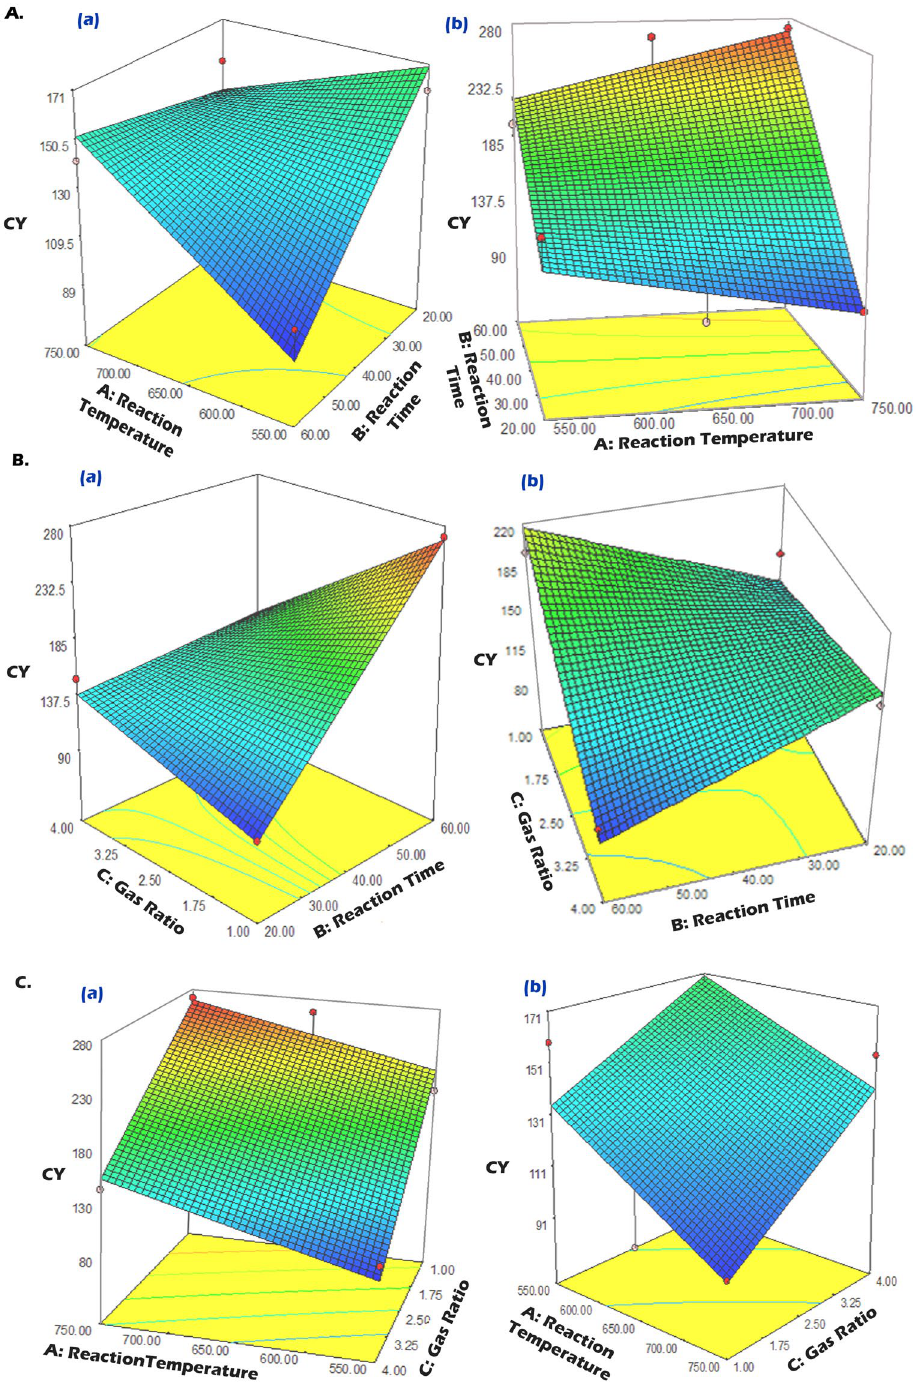
Figure 3. Response surface plots for the effects of reaction temperature and reaction time on CY at fixed gas ratio 4.0 ( Aa ) and 1.0 ( Ab ); effects of reaction time and gas ratio on CY at fixed reaction temperature 750 ( Ba ) and 550 °C ( Bb ); and effects of gas ratio and reaction temperature on the CY at fixed reaction time 60 ( Ca ) and 20 min ( Cb